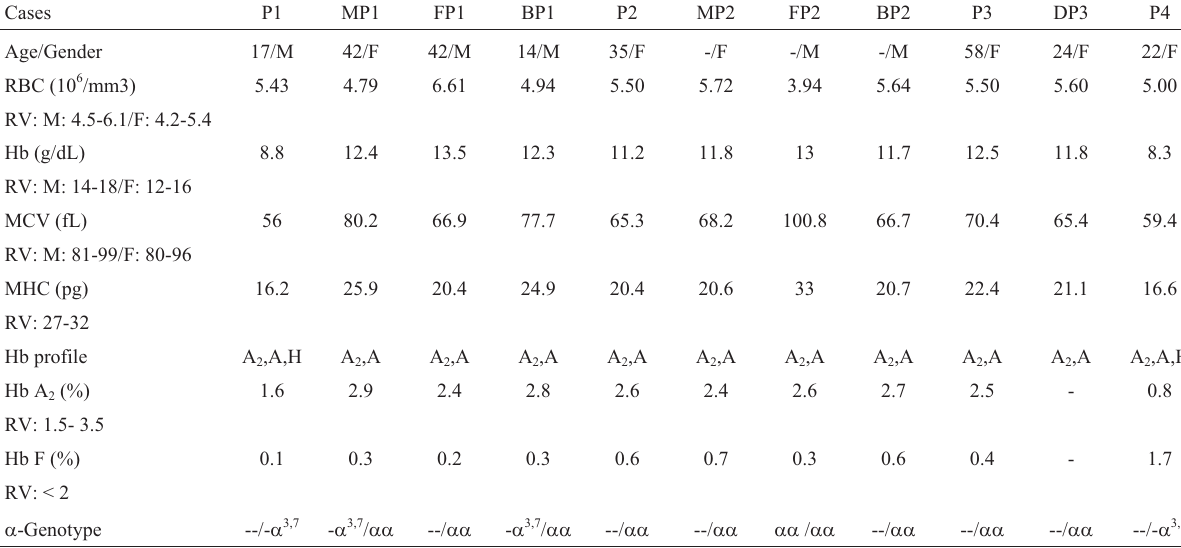
Table 1 - Hematological and molecular data of Patients P1 - P3 and their families, and P4.